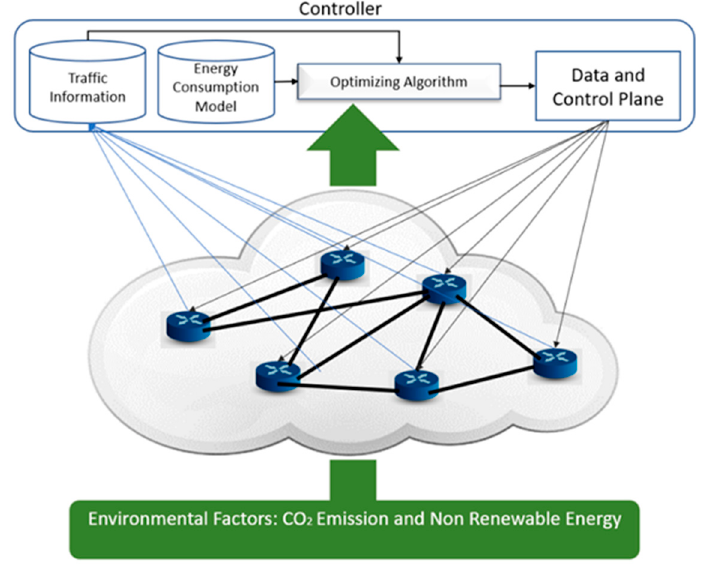
Figure 1. Basic Architecture of the System.